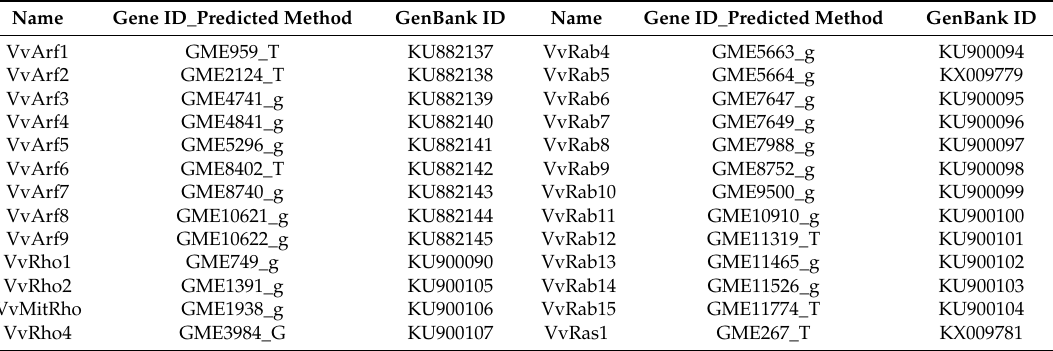
Table 1. The sequences information of 44 Small GTPase of Volvariella volvacea